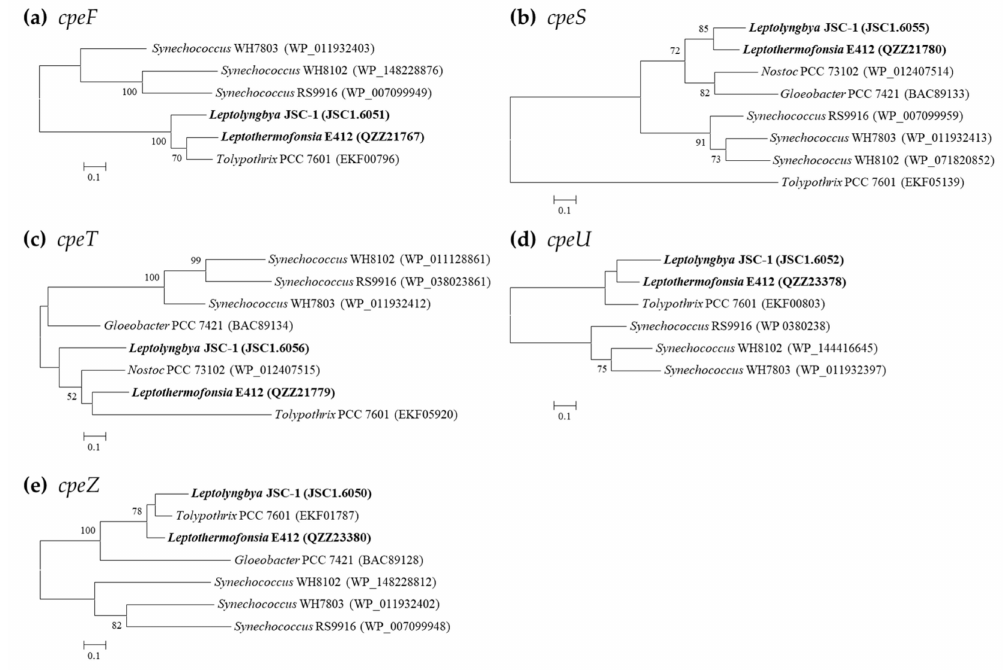
Figure 5. Phylogenetic inference of protein sequences encoding PE-associated phycobilin lyases. The thermophilic cyanobacteria surveyed in this study are indicated in bold. Only bootstrap values > 50% are indicated at nodes. ( a ) cpeF , ( b ) cpeS , ( c ) cpeT , ( d ) cpeU , ( e ) cpeZ